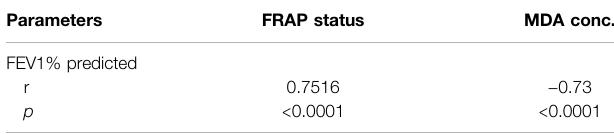
TABLE3| Pearson ’ scorrelationofFEV1%predictedvalueswithFRAPstatusand MDA concentration.